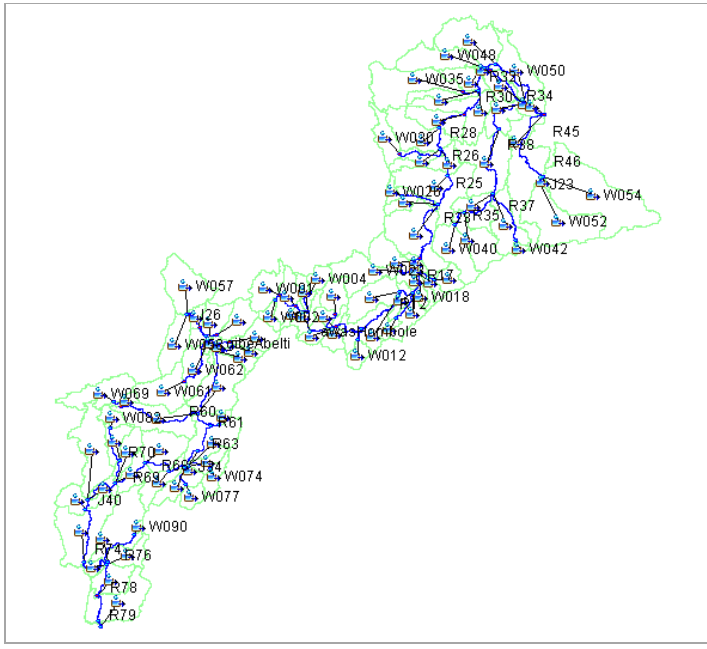
Figure 3. Processed HEC-HMS and schematization basin model for simulation.